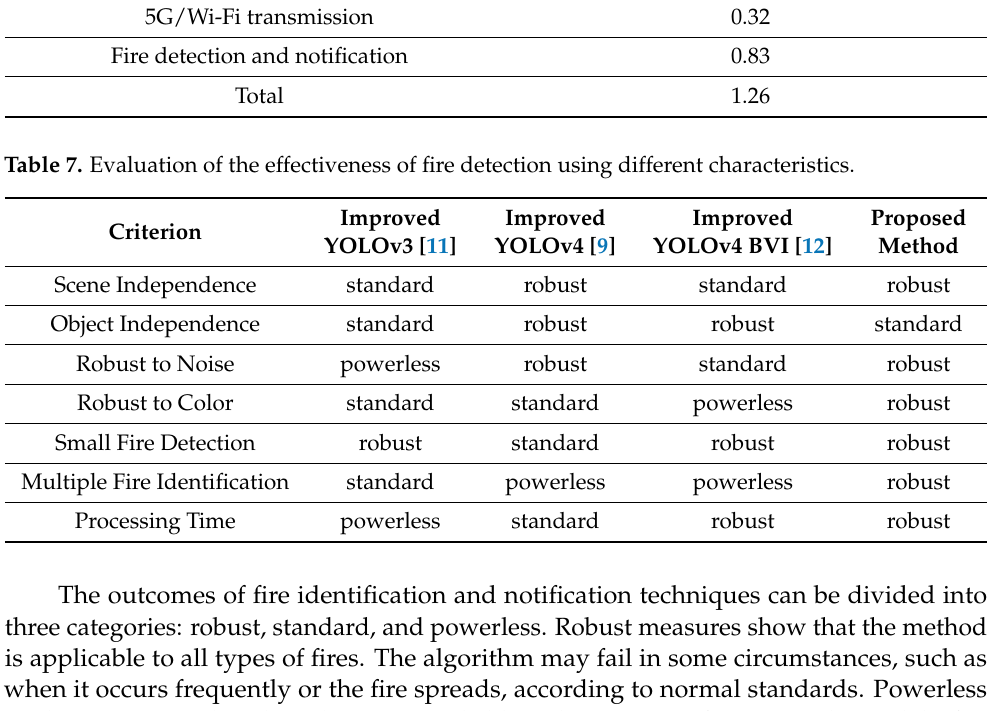
Table 7. Evaluation of the effectiveness of fire detection using different characteristics.